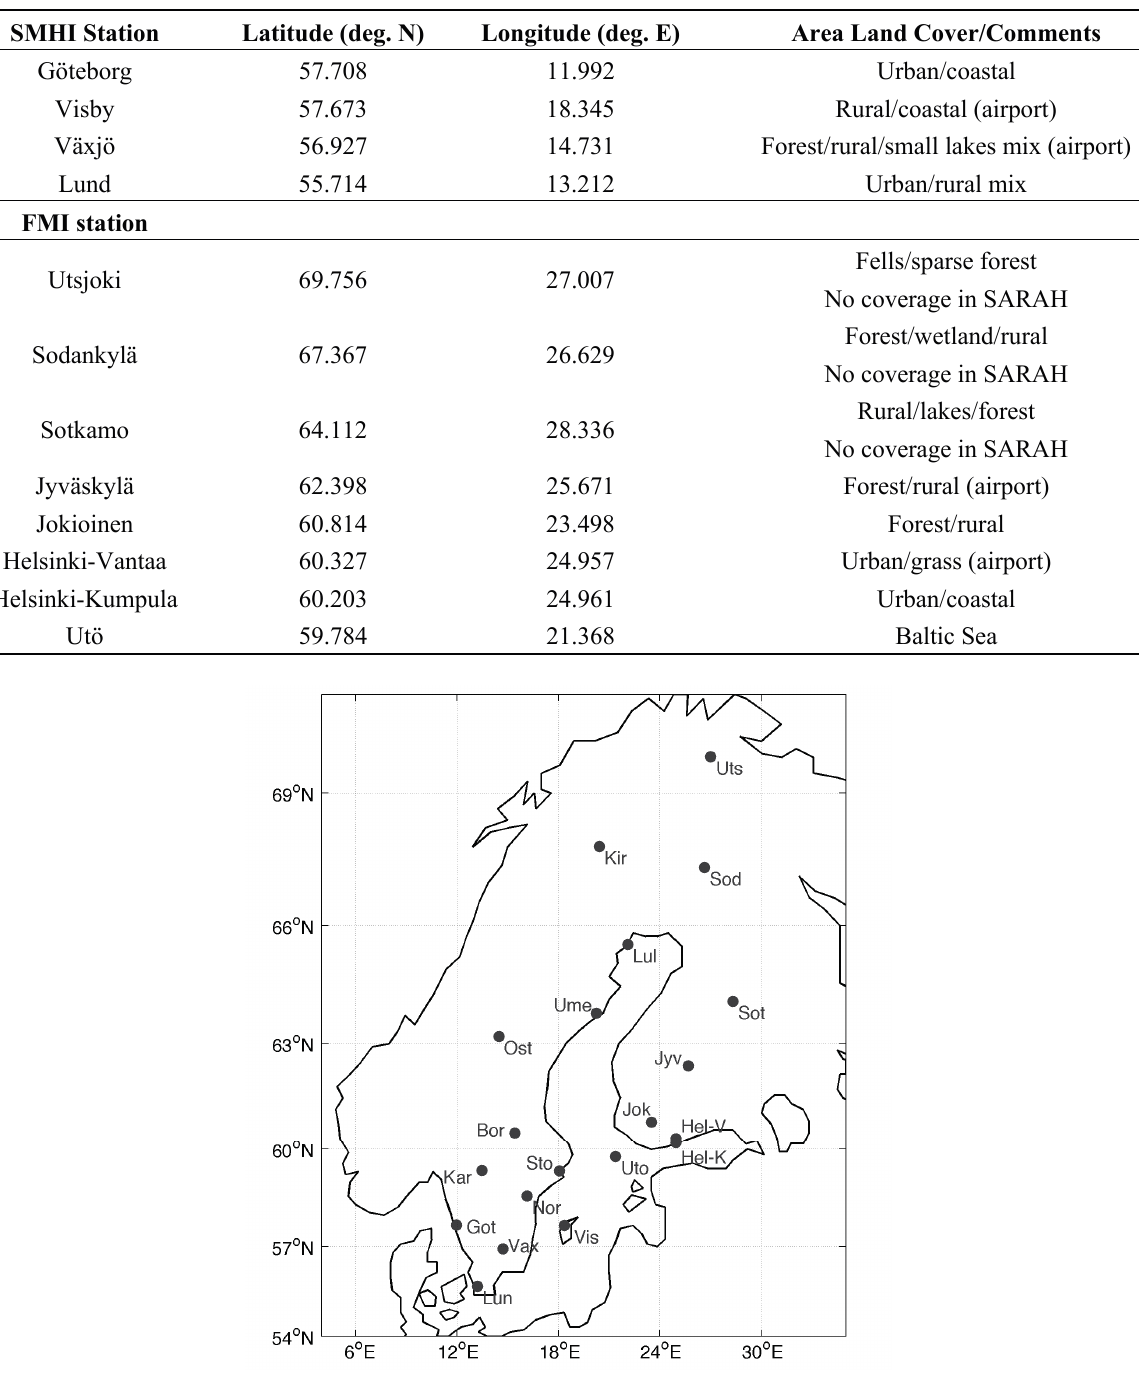
Figure 3. Validation site locations in Finland and